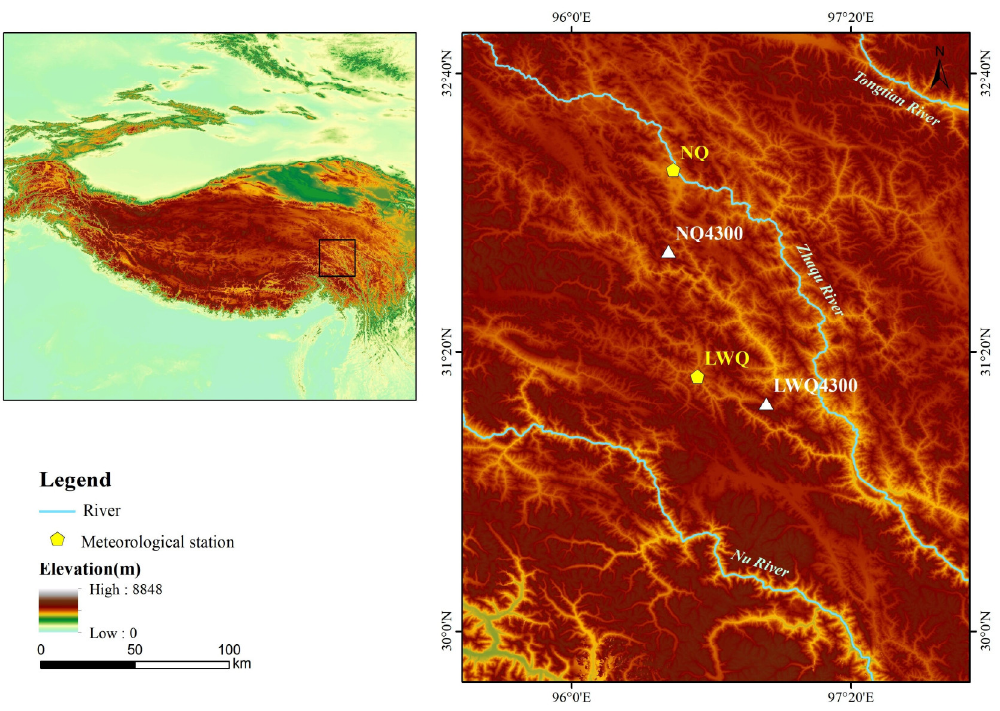
Figure 1. Location of the two study sites (white triangles in the right map) and the meteorological stations (yellow pentagons in the right map) situated on the eastern TP (upper left).